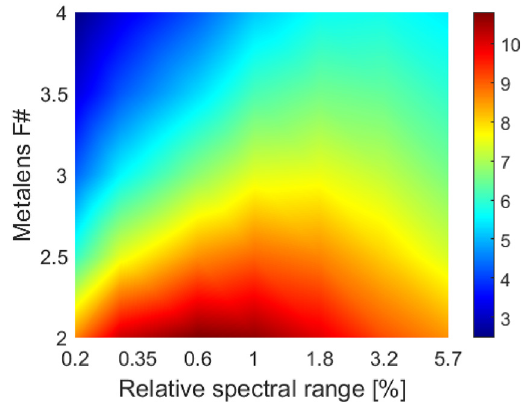
Figure 2: EOPM for a conventional diffractive lens as a function of F # and relative spectral bandwidth Δλ∕λ . For a given F #, one can determine the optimal operating